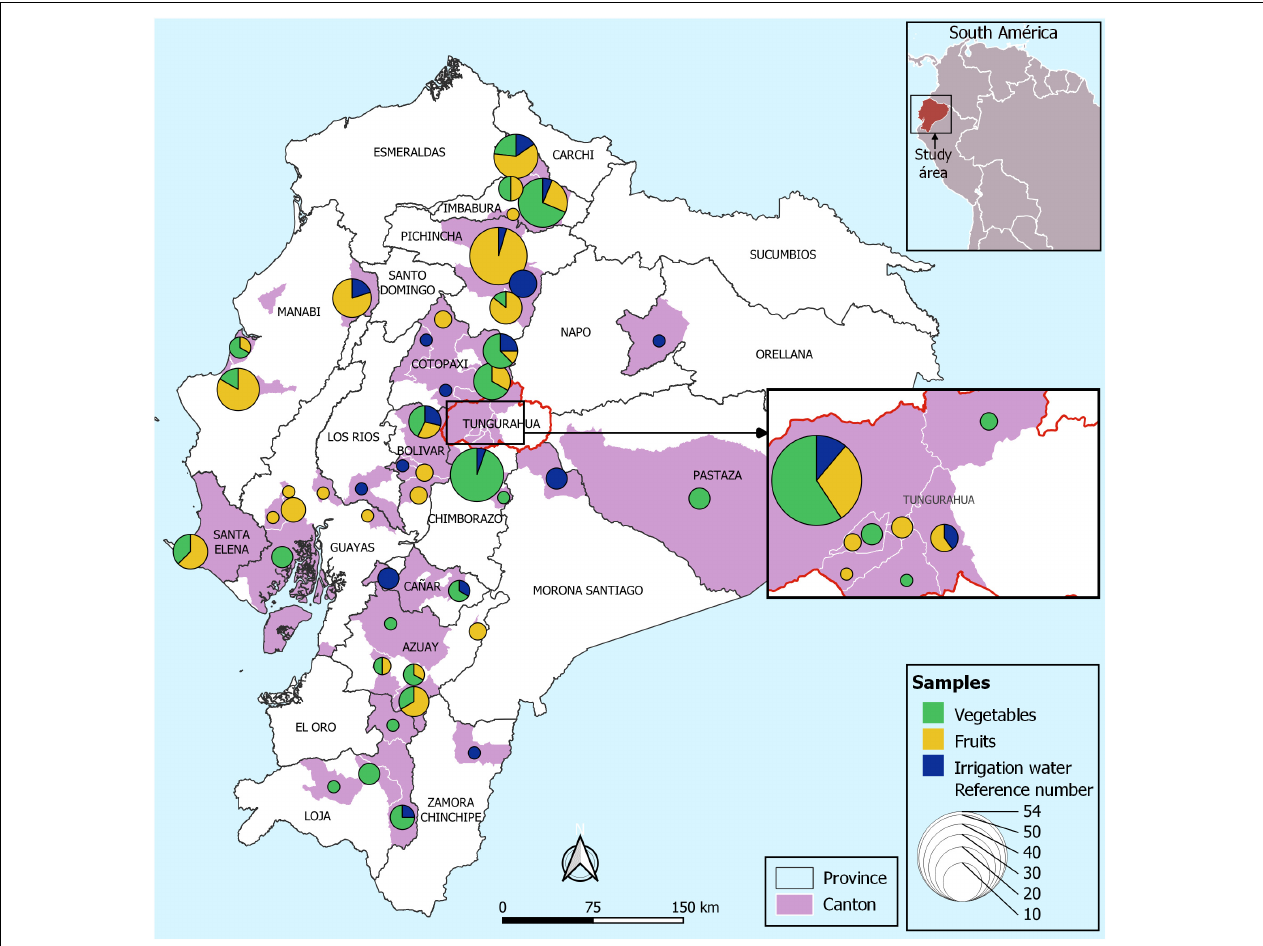
FIGURE 1 | Map of Ecuador showing the sampling locations. Map of sampling locations of irrigation water, fruits and fresh produce. The circles represent the total number of samples according to the color assigned to each sample (vegetables: green, fruits: yellow, and irrigation water: blue) collected in each canton